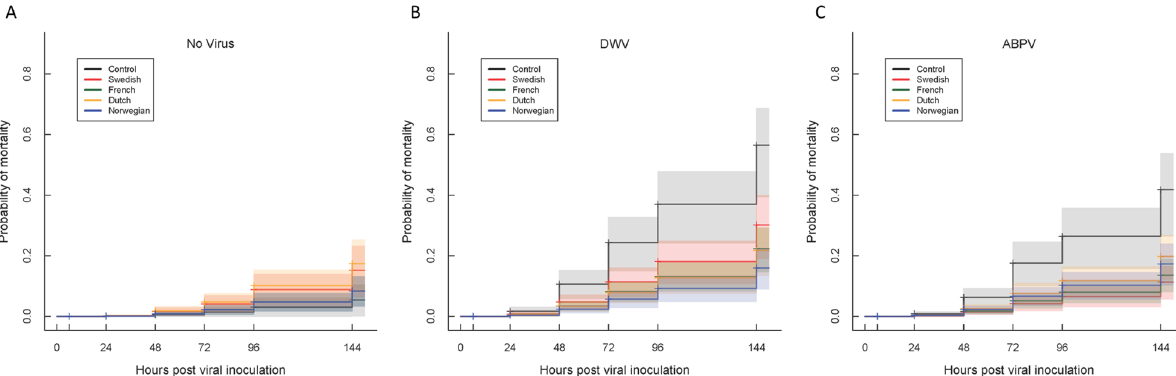
Figure 2. Cox Proportional Hazard curves for the Dutch, French, Norwegian and Swedish varroa-resistant honeybee populations and the varroa-susceptible Control population for the non-inoculated ( A ), DWV- inoculated ( B ) and ABPV-inoculated ( C ) adult bee virus infection experiments. The shaded areas represent the 95% confidence intervals for the proportional hazard lines, based on the data from four replicate